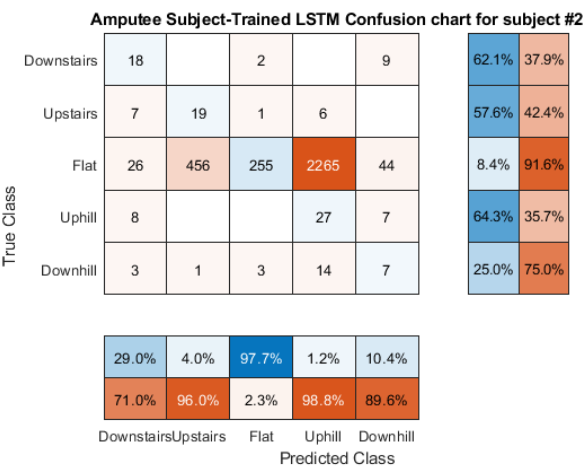
Figure A20. Long Short-Term Memory Network Confusion Chart for ILLA participant A2 as trained by all other ILLA participants.